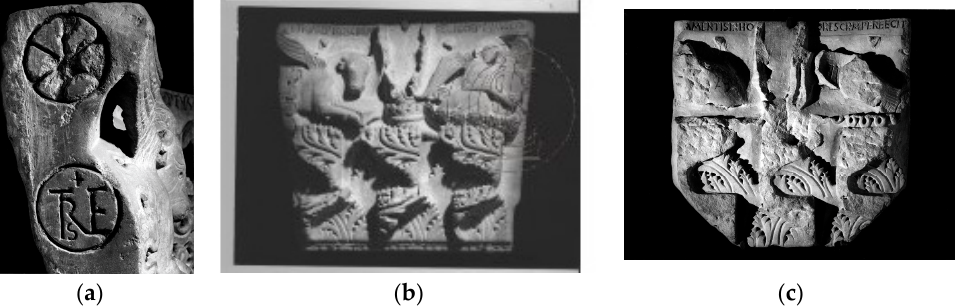
Figure 7. Two zone acanthus leaves capitals, Museo Arcivescovile, Ravenna: ( a ) side of the first capital; ( b ) first capital; ( c ) second capital (photos: courtesy of Istituzione Biblioteca Classense, Ravenna, Fondo Mazzotti).